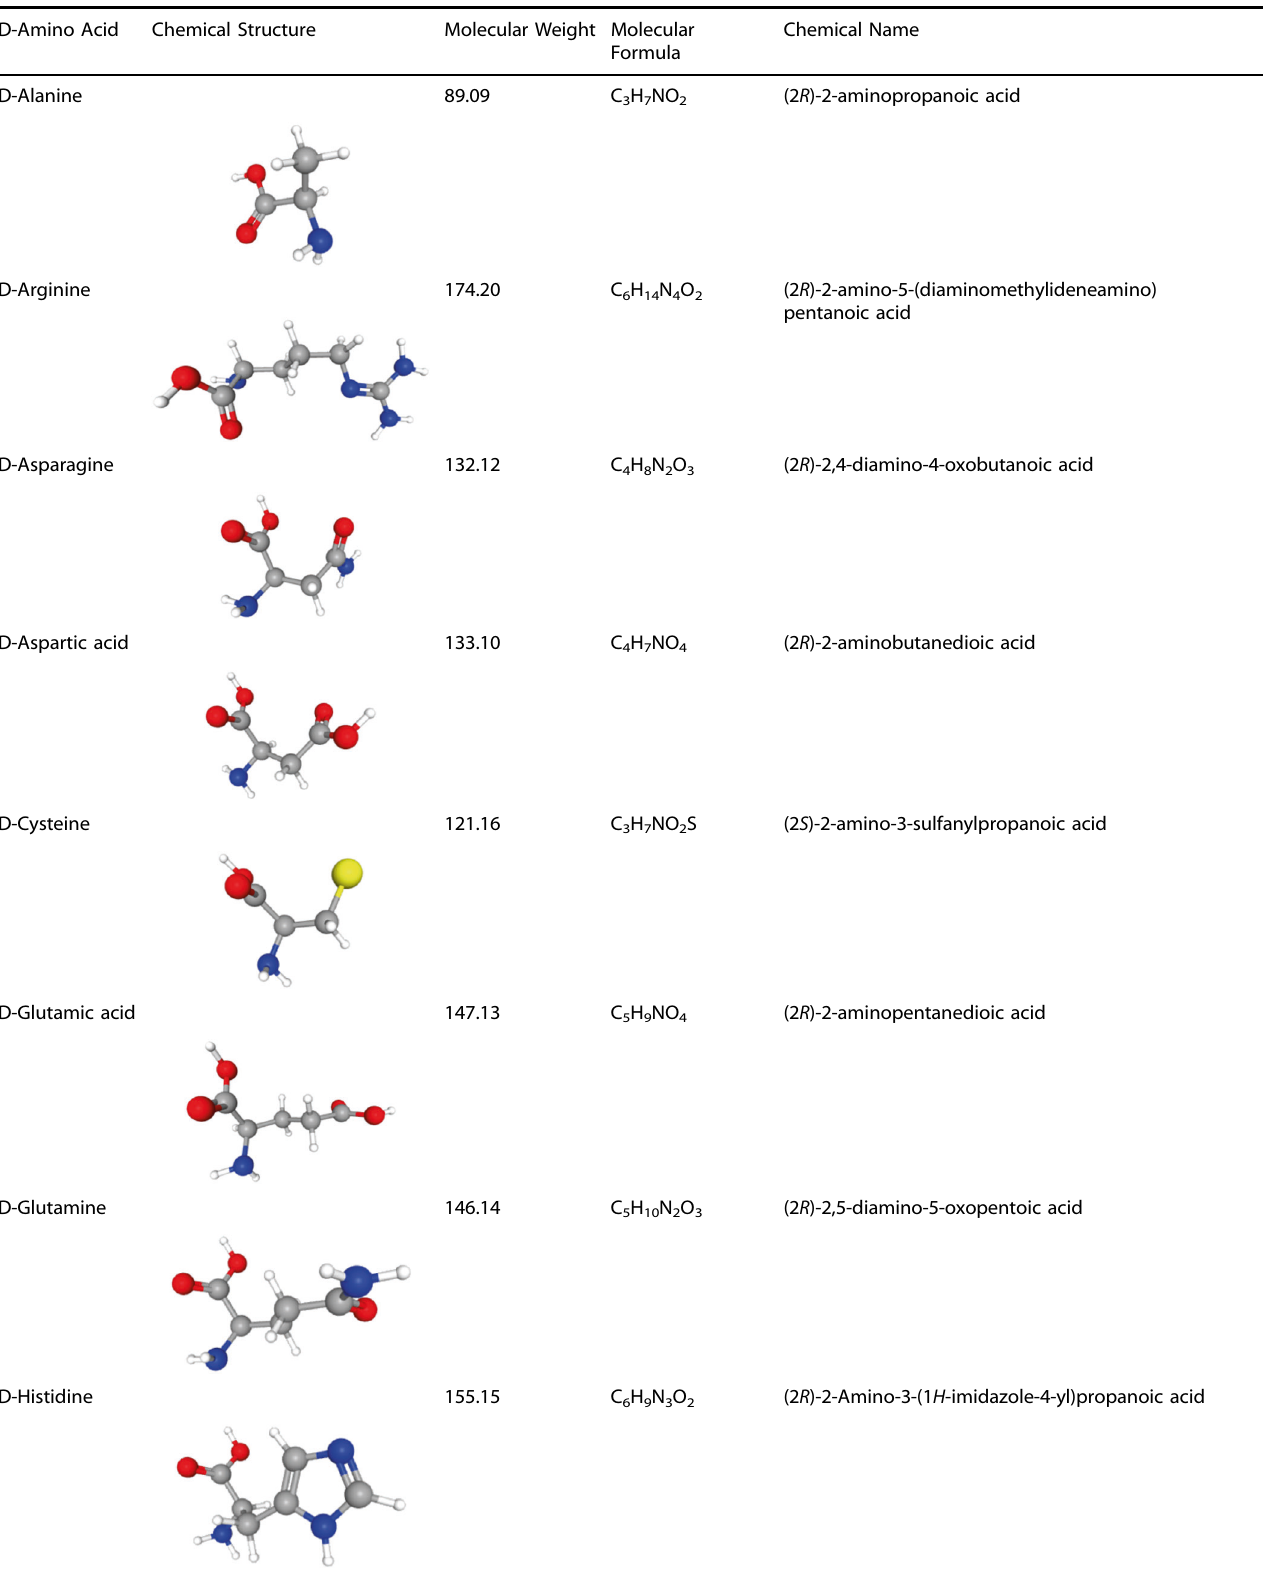
Table 1. A table presenting the chemical structure, molecular weight, chemical formula, and chemical name of the D-AAs D-Amino